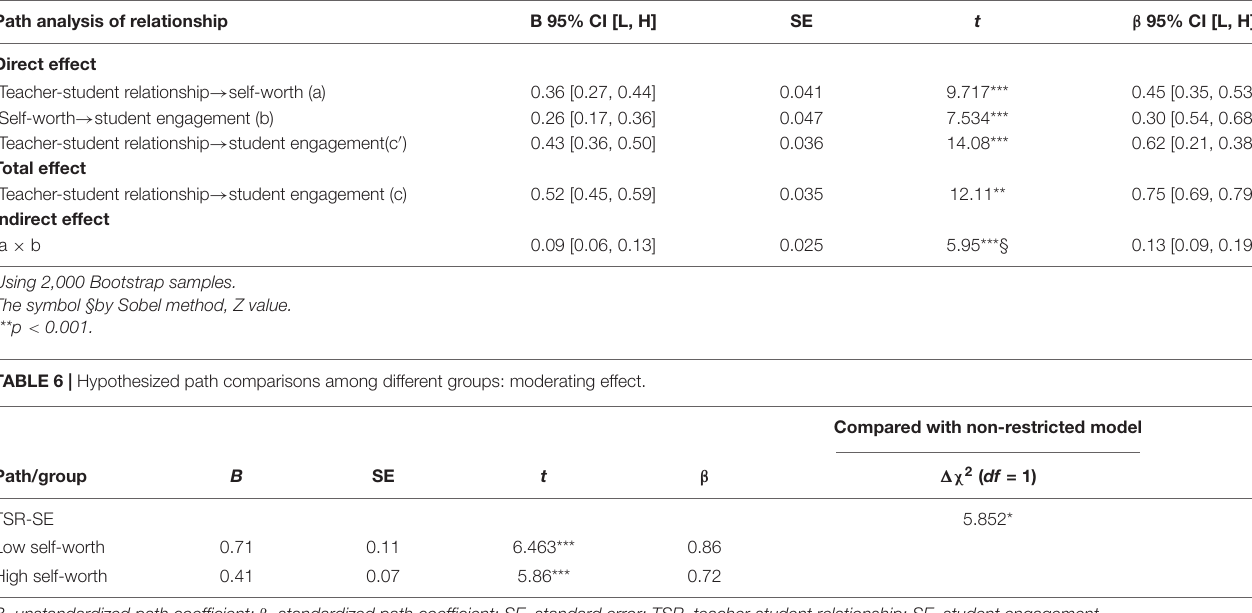
TABLE 5 | Estimators of structural equation modeling (SEM) for mediator.